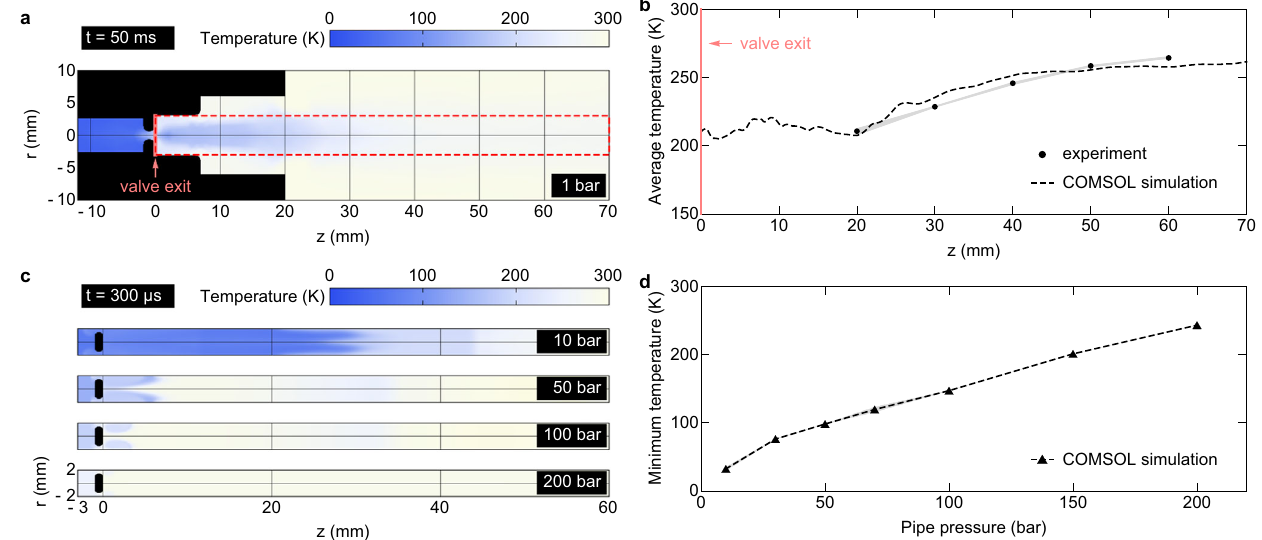
Fig. 2 A temperature drop of an expanding fl uid by COMSOL Multiphysics simulation compared with the experiments. a The buffer chamber with 300 bar suddenly expands to an open space having 1 bar. b The experimental measurement is compared with the time- and space-averaged temperature in the simulation results (0 – 200 ms, red dashed area). c A set of simulations shows the fl uid expansion through the check valve of the compressor outlet to the pipe connecting to the main chamber as a function of the initial pipe pressure. d Minimum temperatures for different pipe pressures. The error bands are the standard deviations of each